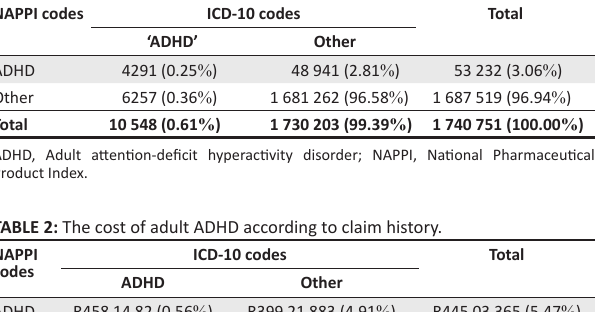
TABLE 1: The prevalence of adult ADHD according to claim history.